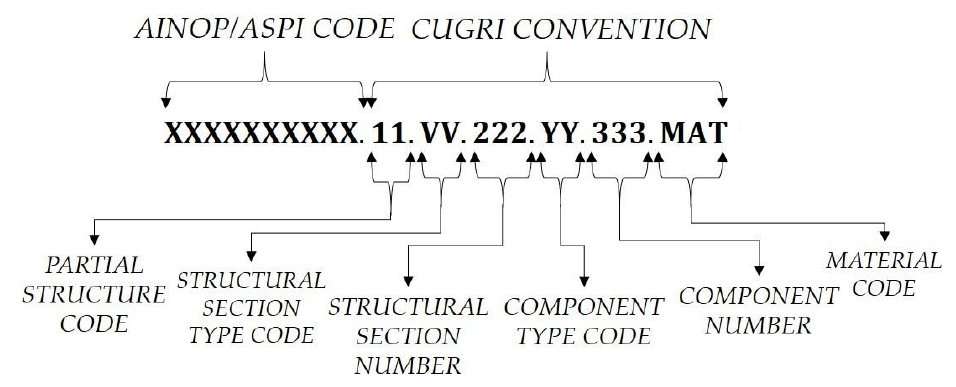
Figure 9. Bridge single element ID code.